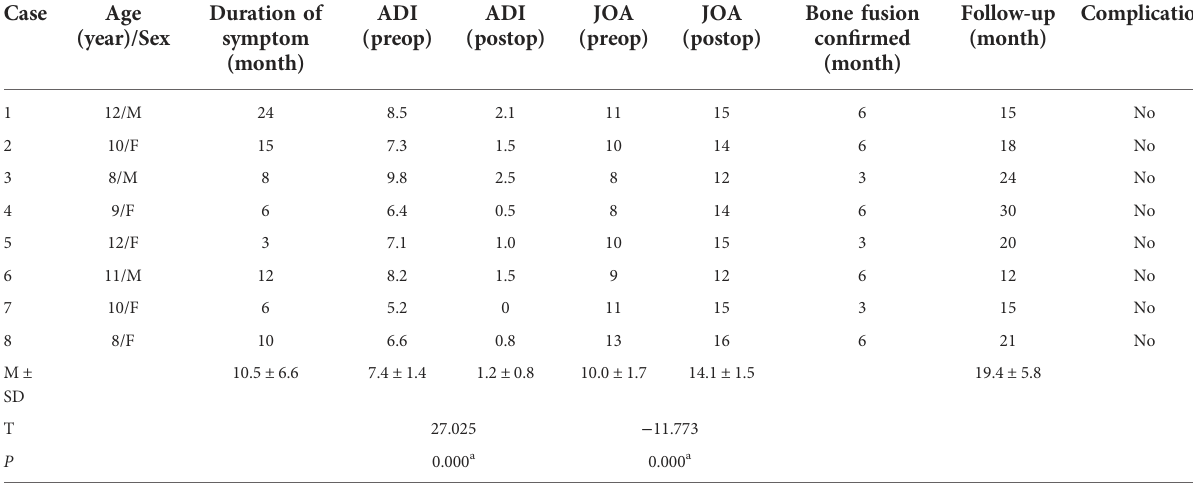
TABLE 1 Pre- and postoperative data of the 8 patients.